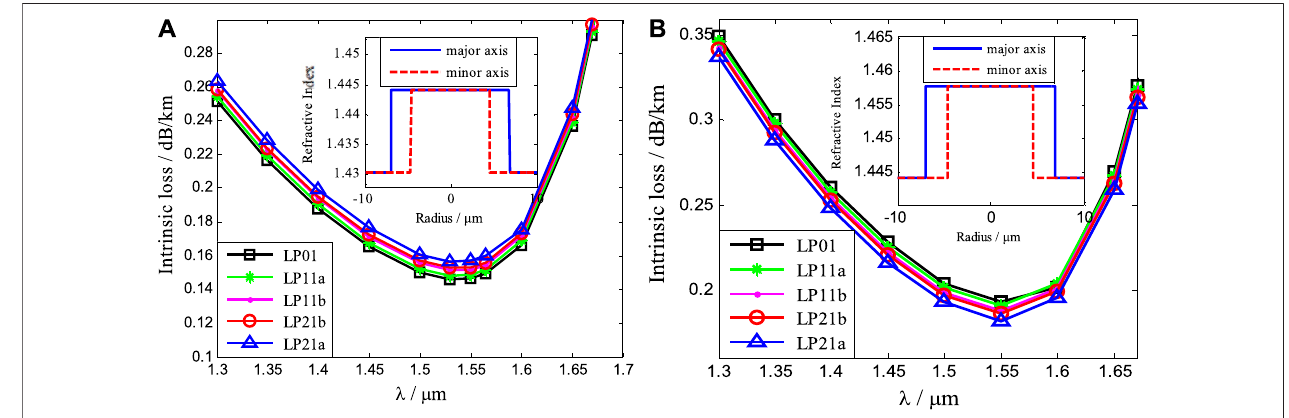
FIGURE 9 | Variations of intrinsic losses of our proposed EFMF with pure silica core (A) and the conventional FMF with elliptical GeO 2 -doped core (B) with the incident wavelength.